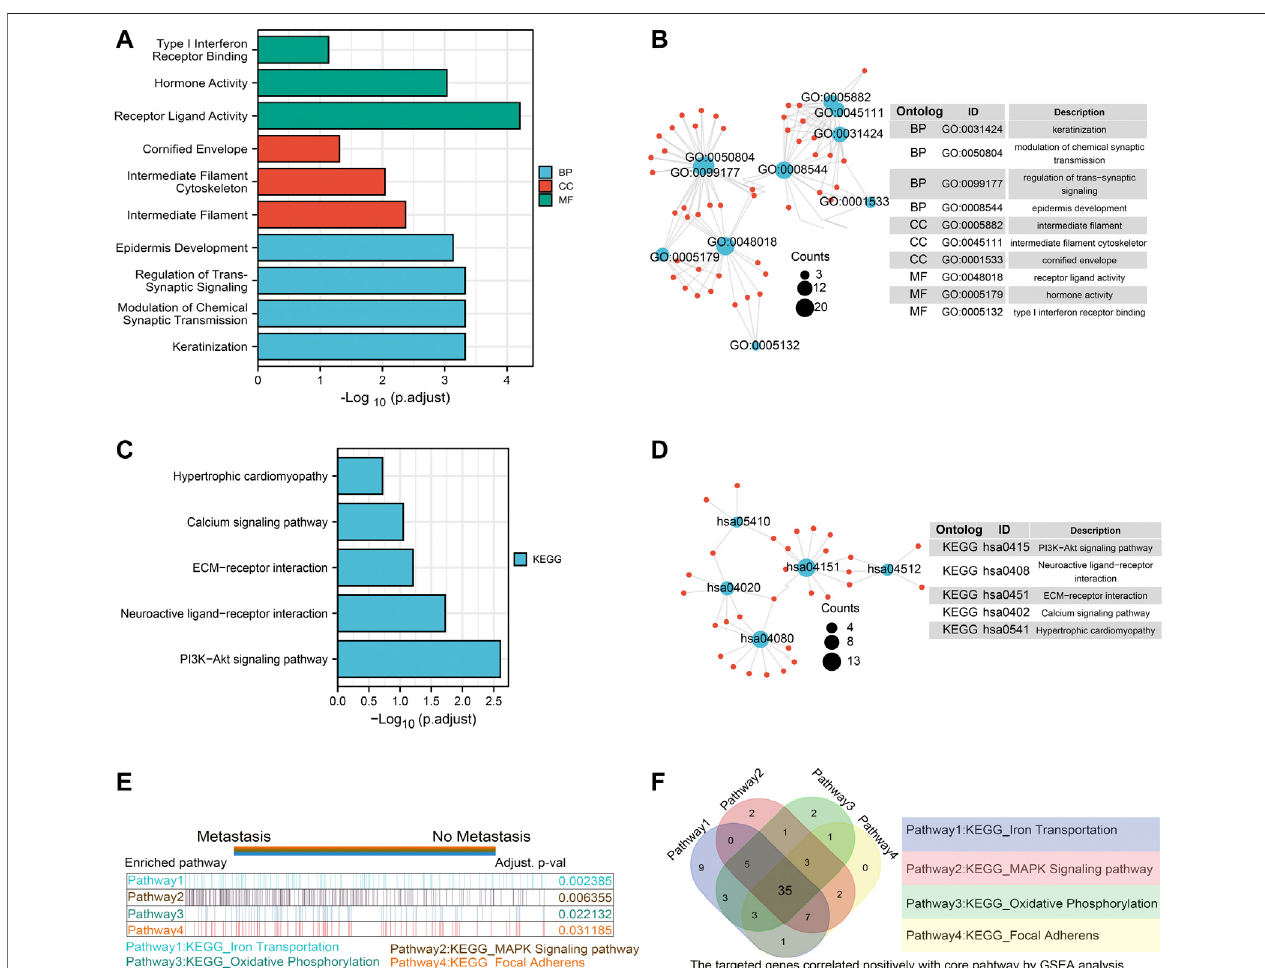
FIGURE 2 | Functional enrichment analysis of ferroptosis related DEGs and Screening of EMT related genes by GSEA. GO enrichment analysis of DEGs. Blue represents Biological Process, red represents Cellular Component, and green represents Molecular Function (A,B) ; KEGG enrichment analysis of DEGs. Color gradient represents p value. The size of the circle represents the number of enrichment (C,D) ; The gene set enrichment analysis (GSEA) was conducted between “ metastasis ” group and “ without metastasis ” group, the core pathways were selected, p value < 0.05, FDR < 0.25 (E) ; the correlation analysis was performed between the 74 DEGS and gene sets from four core pathways, the results were shown with venn diagram (F) .